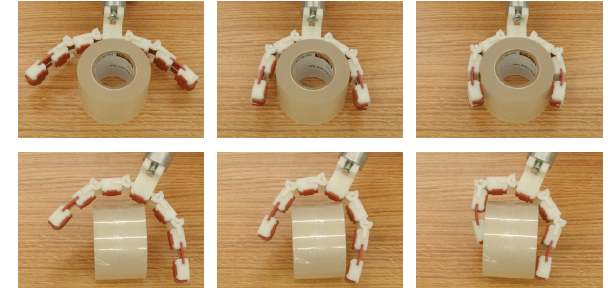
Fig. 7. TWO GRASPS (CENTERED AND ASYMMETRICAL) Figure 7. Two grasps (centered and asymmetrical) executed with EXECUTED WITH THE PROTOTYPE GRIPPER. the prototype gripper. Fig. 6. UNBALANCED JOINT FORCES OVER THE SET OF GRASPS IN THE OPTIMIZATION POOL. Table 1. RESULTS OF GRIPPER DESIGN OPTIMIZATION.